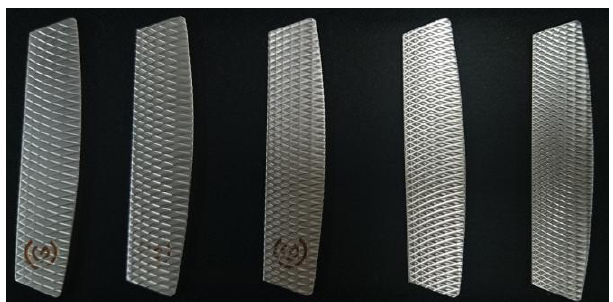
Figure 2. Face caps (Patterns 1–5) used to test relationship between milling pattern and ball speed.